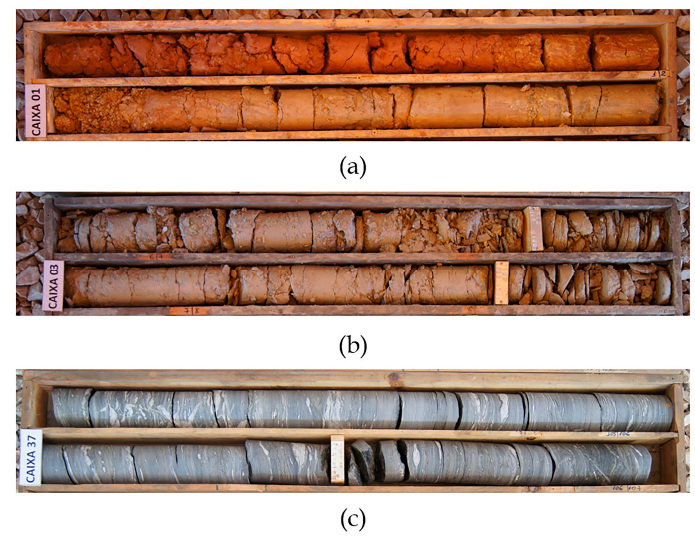
Figure 6. Drillcore samples from the ( a ) saprolite, ( b ) saprock and ( c ) fresh bedrock.